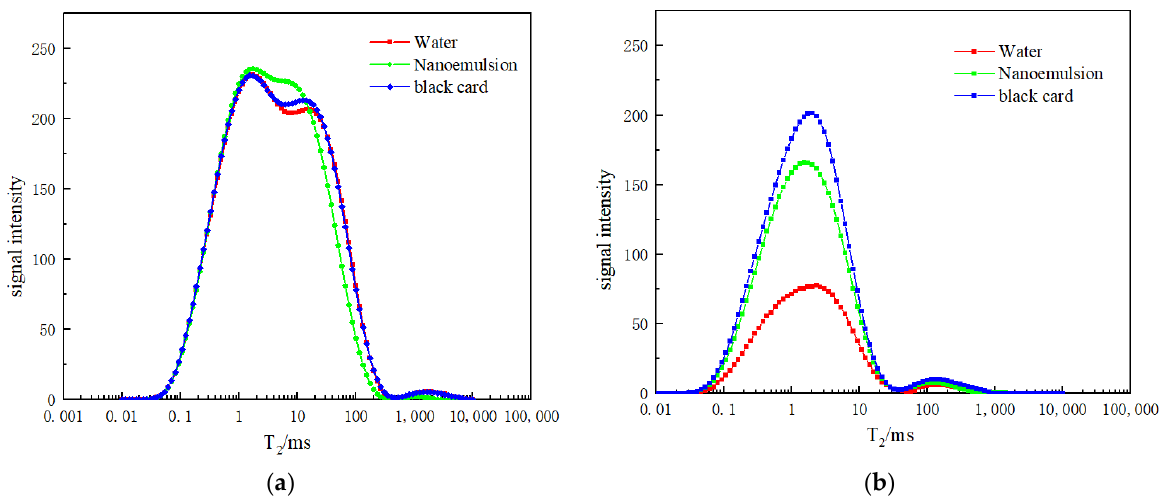
Figure 5. ( a ) T 2 spectrum after saturated water; ( b ) T 2 spectrum after forward-directional imbibition.